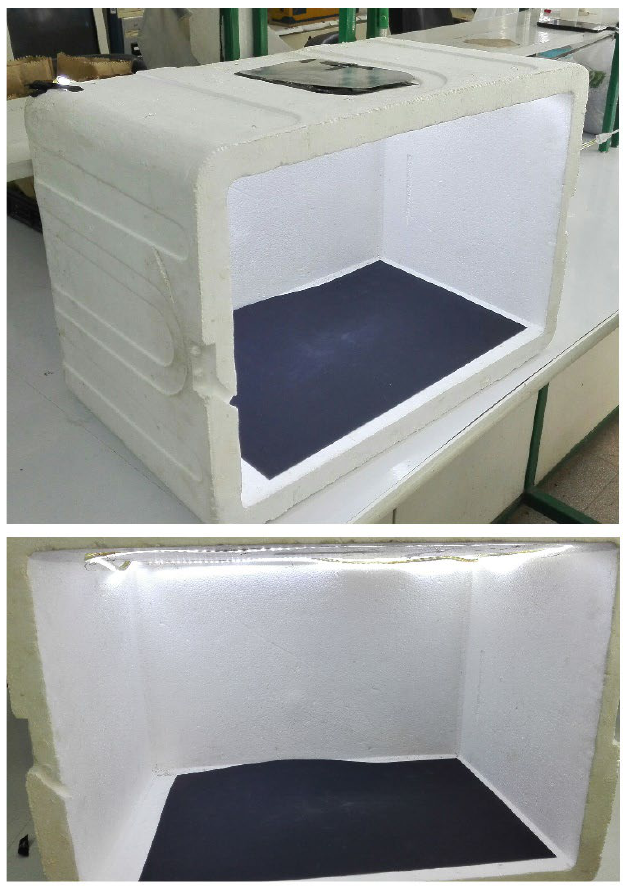
Figure 2. The imaging box in operation with the lid